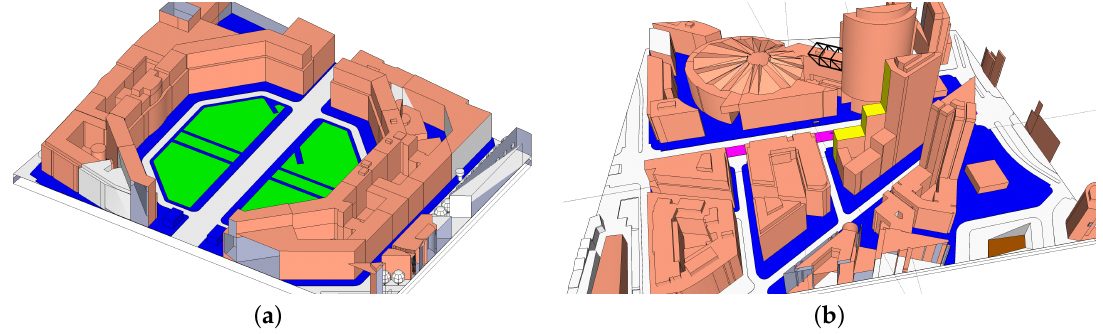
Figure 2. Top view of 3D models used for ray tracing. ( a ) OS-CC scenario; ( b ) “street canyon, city center” (SC-CC)